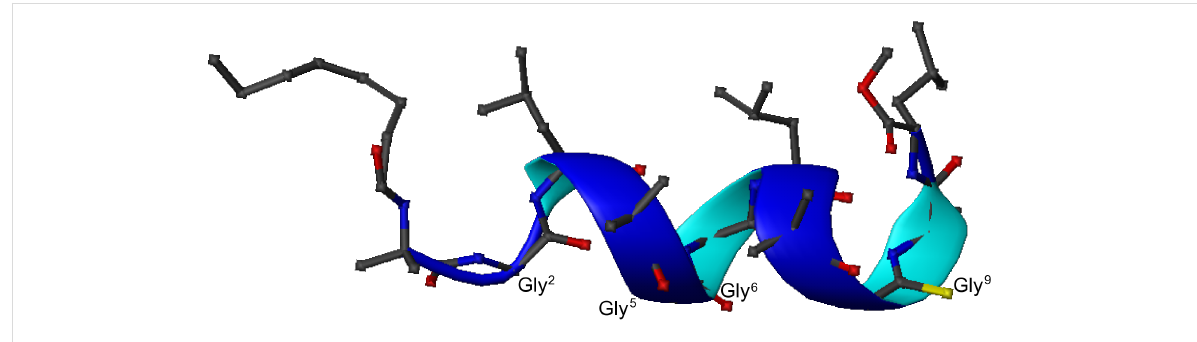
Figure 8: Ribbon representation of the lowest energy (138.7 kcal/mol) 3D structure obtained for ψ [CS-NH] 9 . All amino acid side chains are shown. The yellow atom on Gly 9 refers to sulfur.